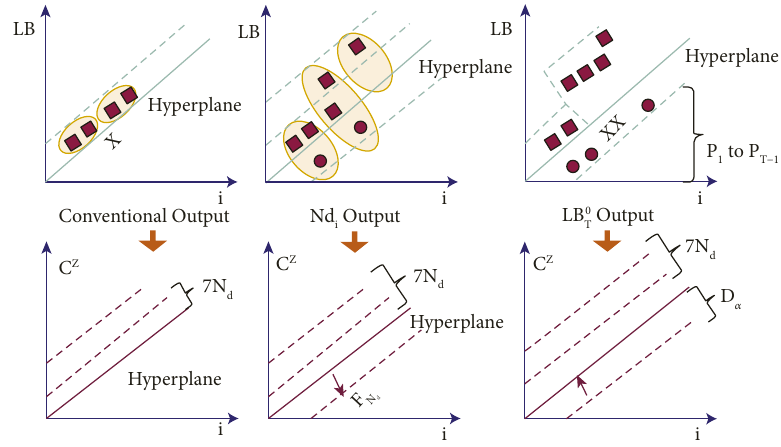
Figure 3: Classification based on LB and ∁ Z